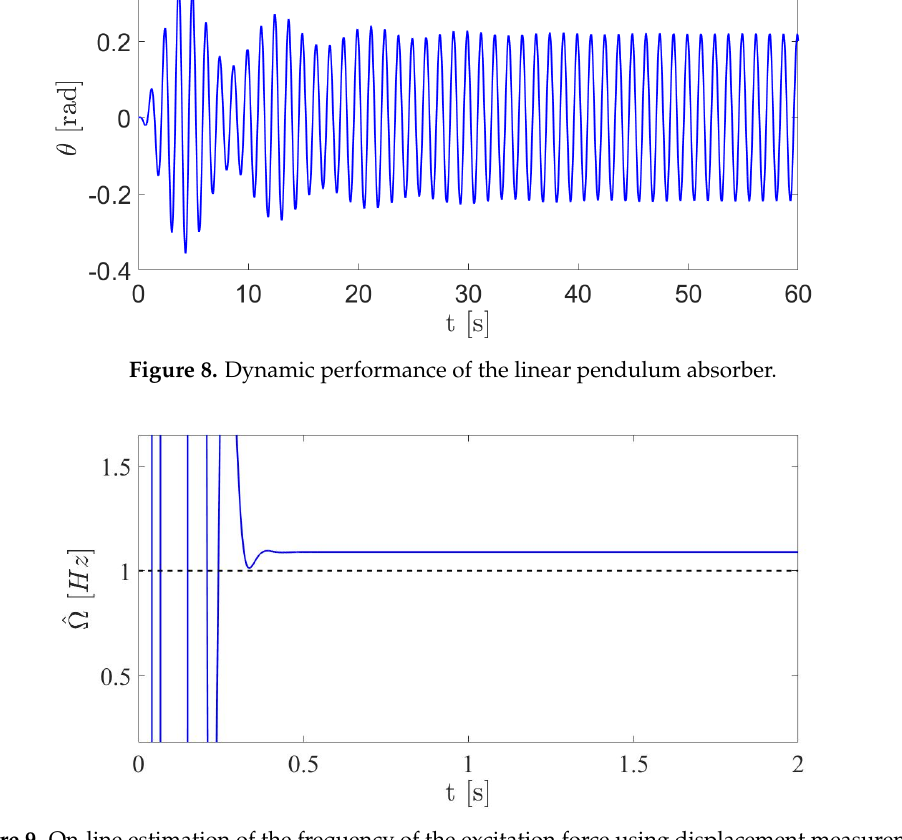
Figure 9. On-line estimation of the frequency of the excitation force using displacement measurements of the sixth floor or degree of